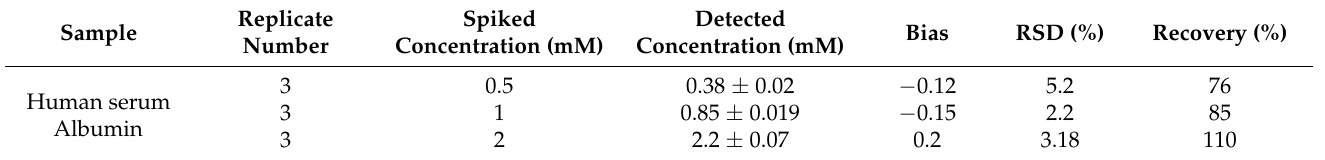
Table 1. Result of real sample